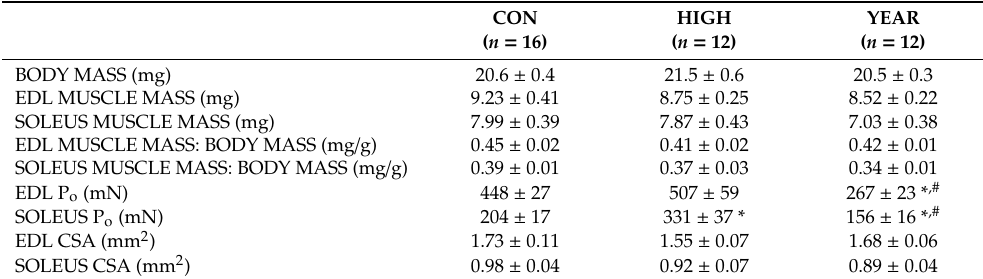
Table 2. Muscle morphometric data.